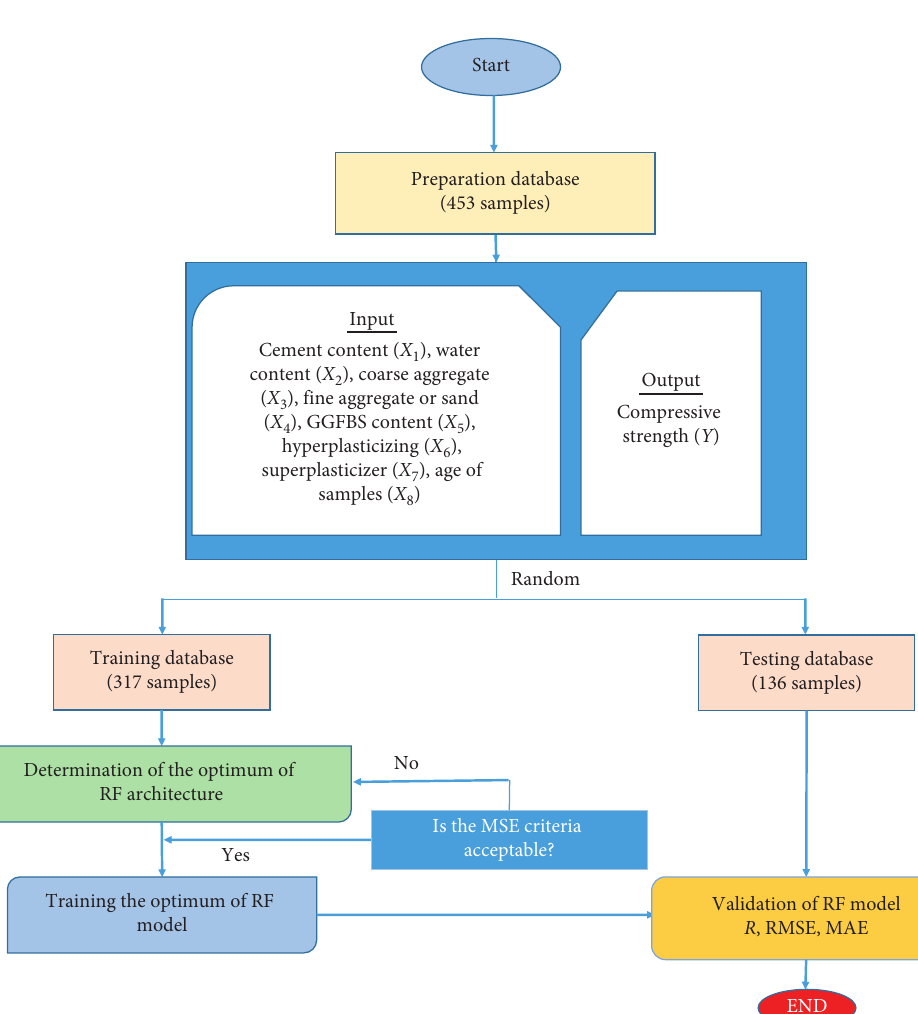
Figure 4: Methodology flow chart.